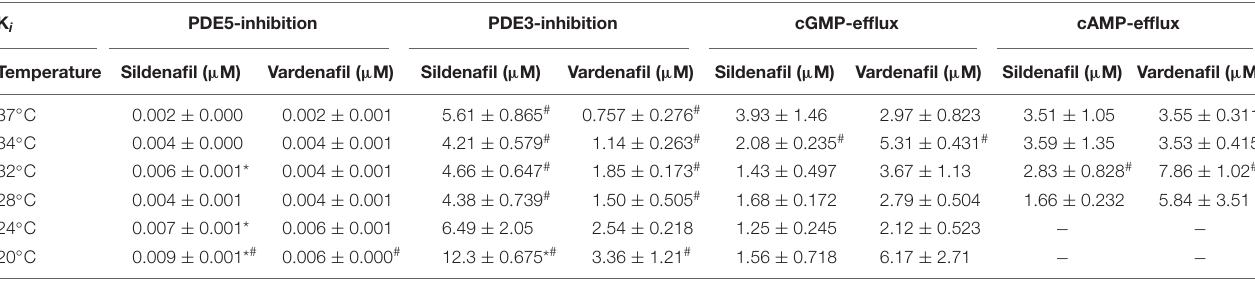
TABLE 5 | K i -values for inhibition of phosphodiesterase-5 (PDE5), phosphodiesterase-3 (PDE3), and inhibition of cAMP- and cGMP-efflux at temperatures ranging from 37 ◦ C to 20 ◦ C.